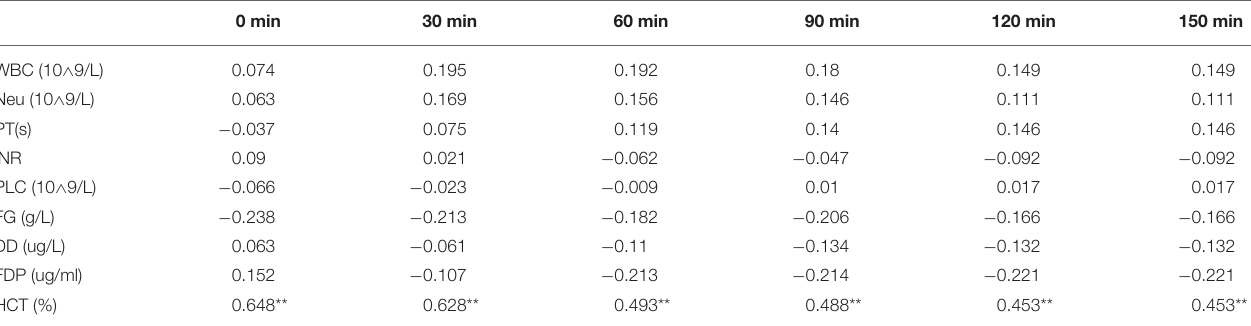
TABLE 2 | The relationship between blood clot of standard group and blood test